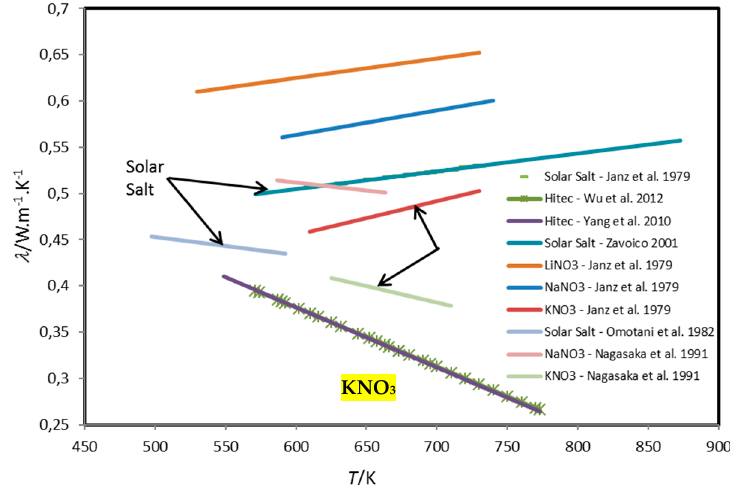
Figure 1. Thermal conductivity of molten alkali nitrates and mixtures. Solar salt is a eutectic binary mixture (NaNO 3 :KNO 3 60 / 40 wt%), while HITEC ® is a eutectic ternary mixture (NaNO 2 : KNO 3 : NaNO 3 7 / 53 / 40 wt%). Adapted from [7].